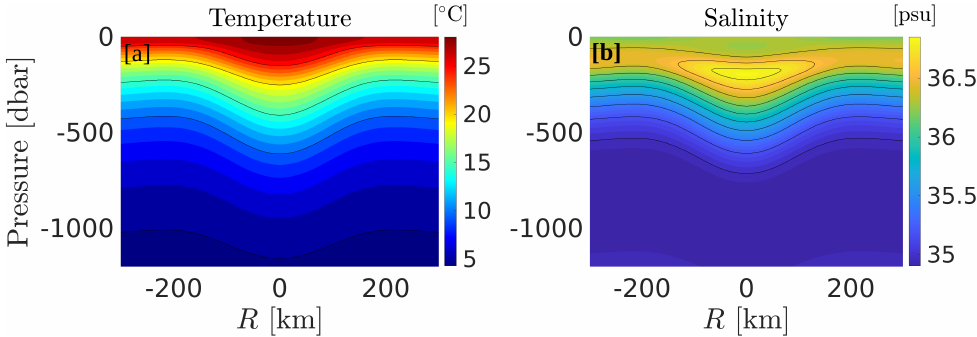
Figure 11. Vertical profiles of temperature ( a ) and salinity ( b ) for the reconstructed average Loop Current ring (LCR). The average LCR is computed using the universal sea surface height (SSH) profile and the Gravest Empirical Mode (GEM) fields. The parameters used in the universal profile are the mean from the 40 least-square